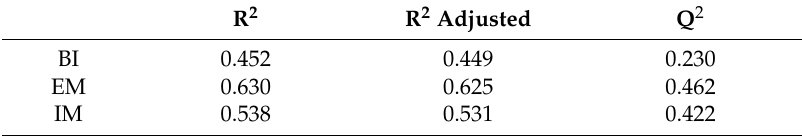
Table 6. The size of the coe ffi cients of determination (R 2 ) and cross-redundancies (Q 2 ). R 2 R 2 Adjusted Q